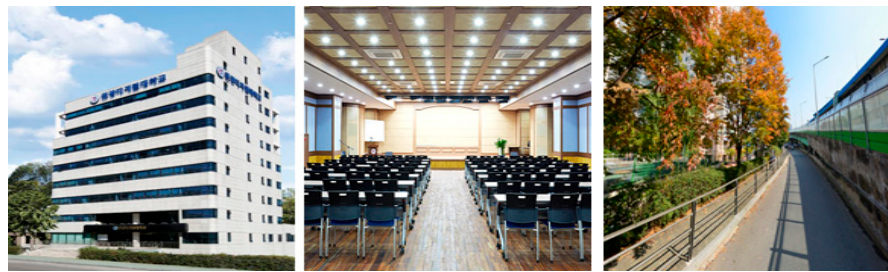
Figure 2. Urban site.